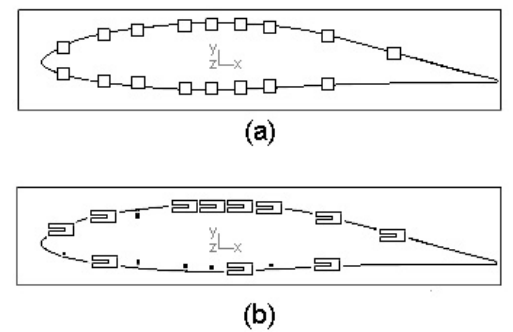
Fig. 5. OPT.TOOL wing analysis. Cross section (case 2) for initial (a) and optimal configuration